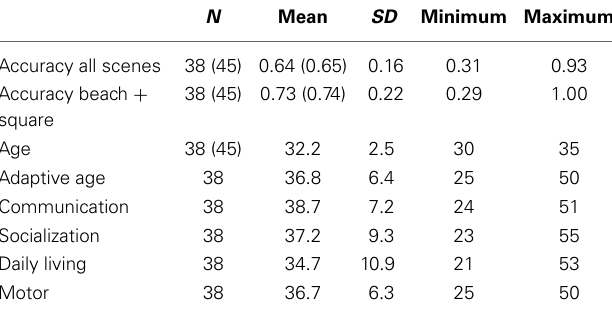
Table 1 | Descriptive statistics for all